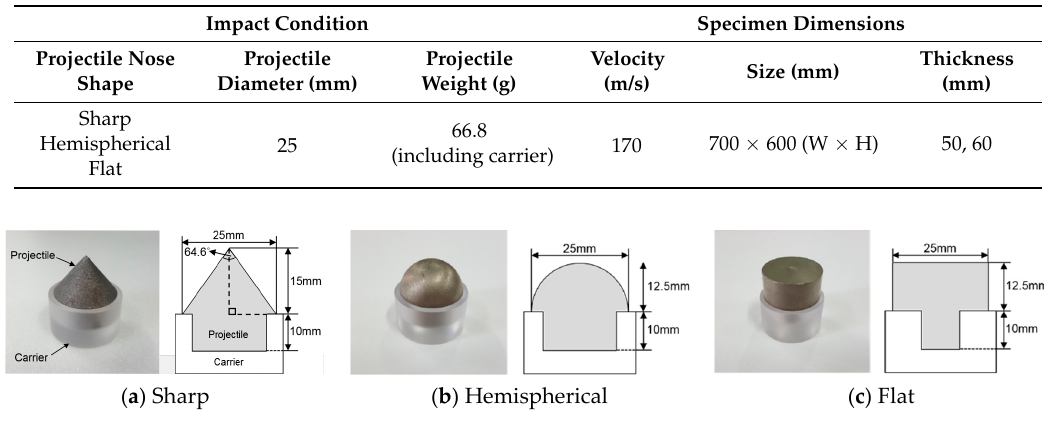
Figure 3. Configuration of projectile nose shapes.